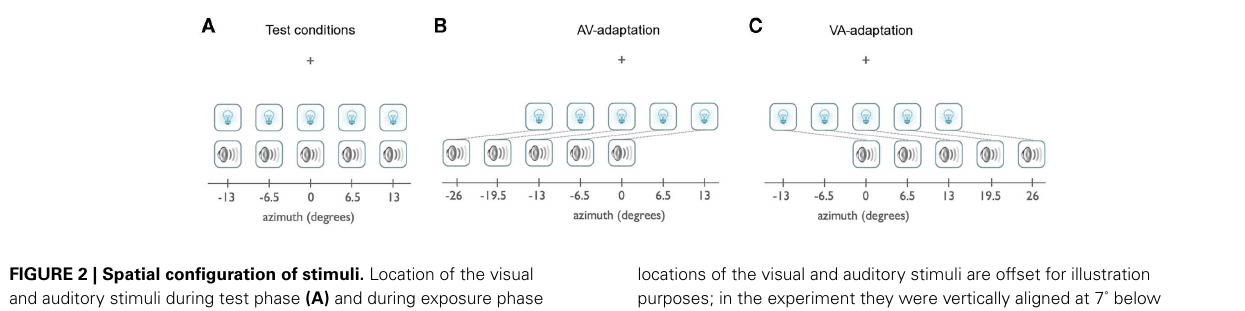
FIGURE 2 | Spatial configuration of stimuli. Location of the visual and auditory stimuli during test phase (A) and during exposure phase for the AV-adaptation group (B) and exposure phase for the VA-adaptation group (C) are schematically shown. Here, the vertical